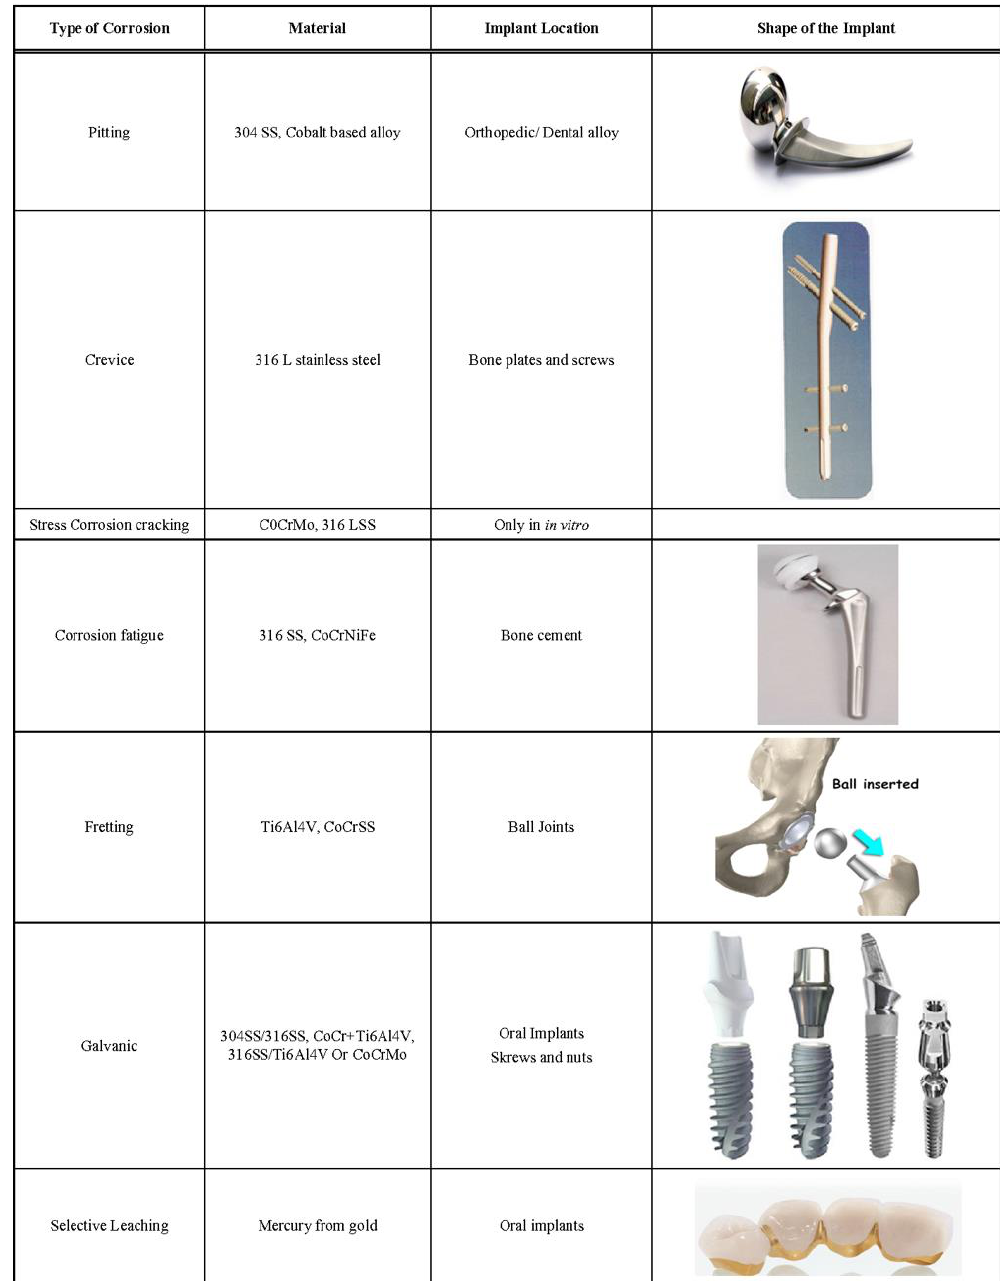
Figure 20. Types of corrosion in common implants [39]. Reprinted with permission from Bentham Science Publishers.